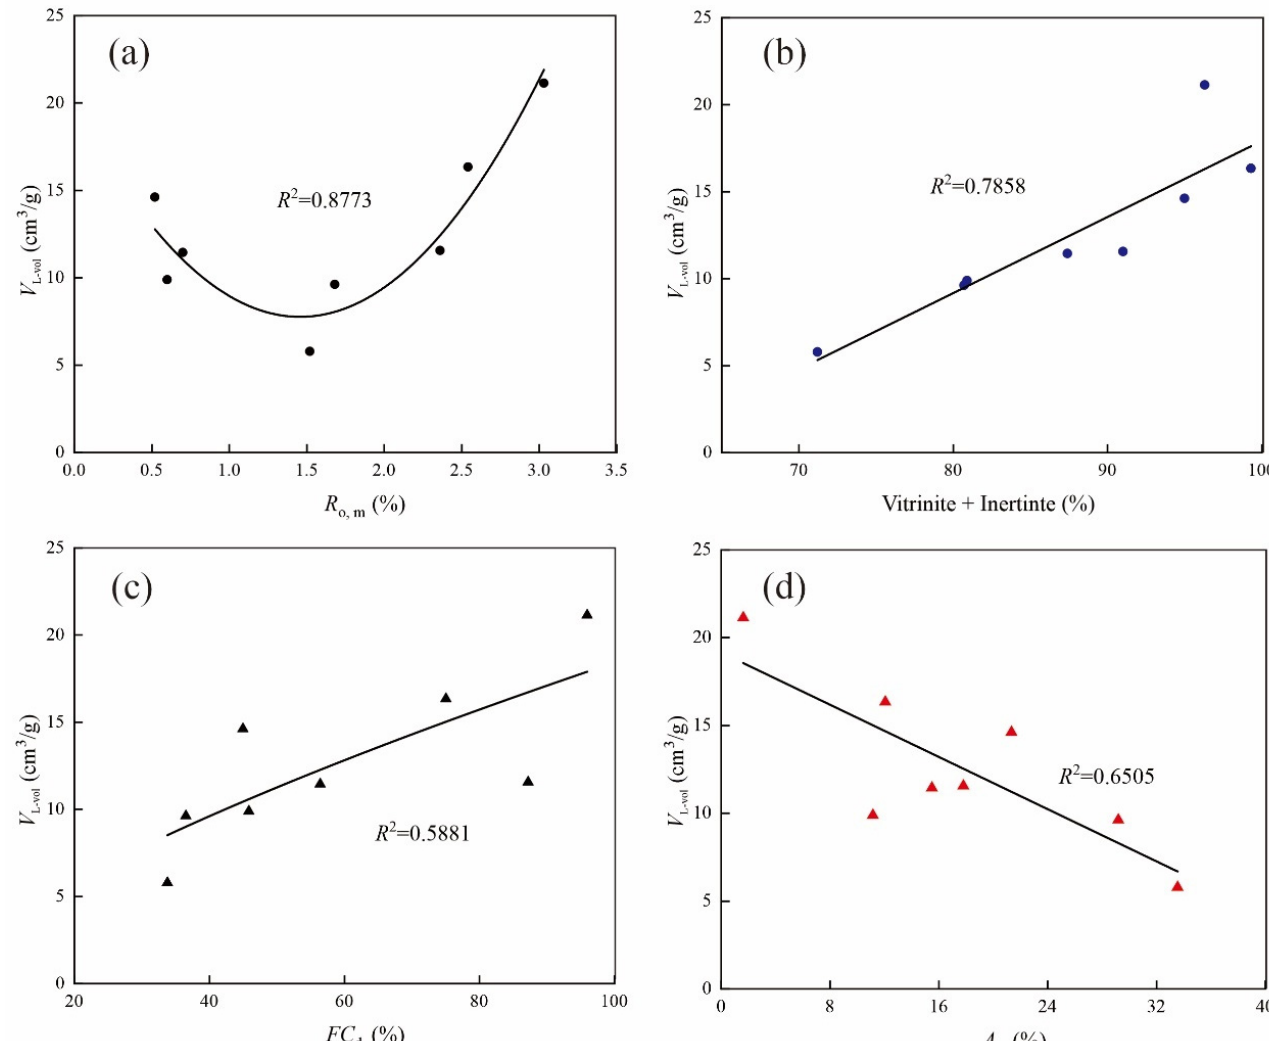
Figure 8. The cross-plots of R o,m , vitrinite + inertinite content, FC d content, and A d content versus Langmuir volume V L-vol . ( a ) R o,m versus Langmuir volume V L-vol , ( b ) vitrinite + inertinite content versus Langmuir volume V L-vol , ( c ) FC d content versus Langmuir volume V L-vol , ( d ) A d content versus Langmuir volume V L-vol .